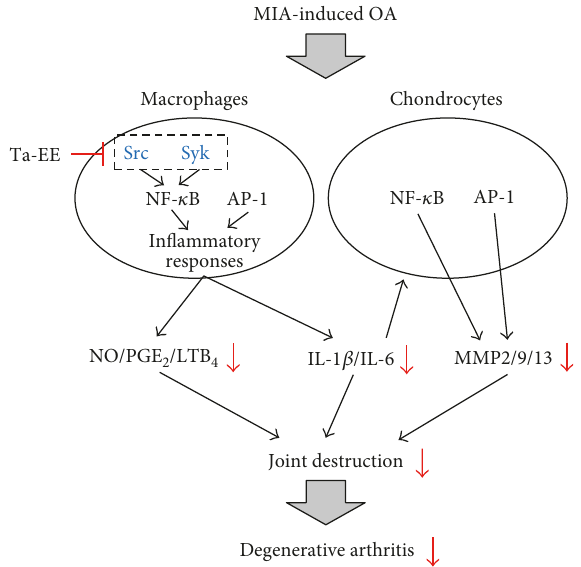
Figure 6: Proposed model showing the inhibitory pathways associated Ta-EE-mediated anti-in fl ammatory and chondroprotective activities in OA